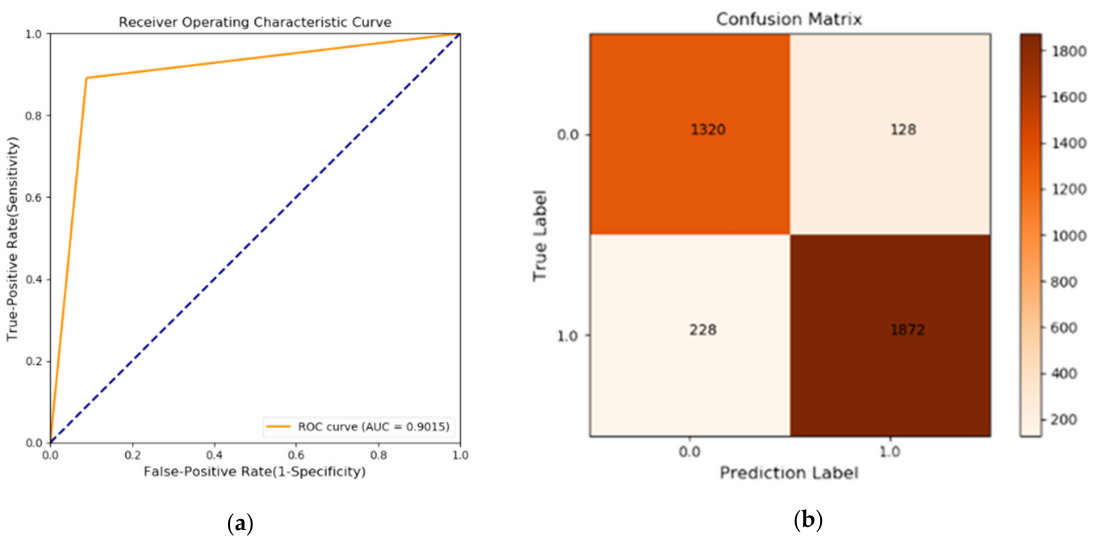
Figure 6. Disease occurrence prediction model classification indicators. ( a ) ROC curve. ( b ) confu- sion matrix.